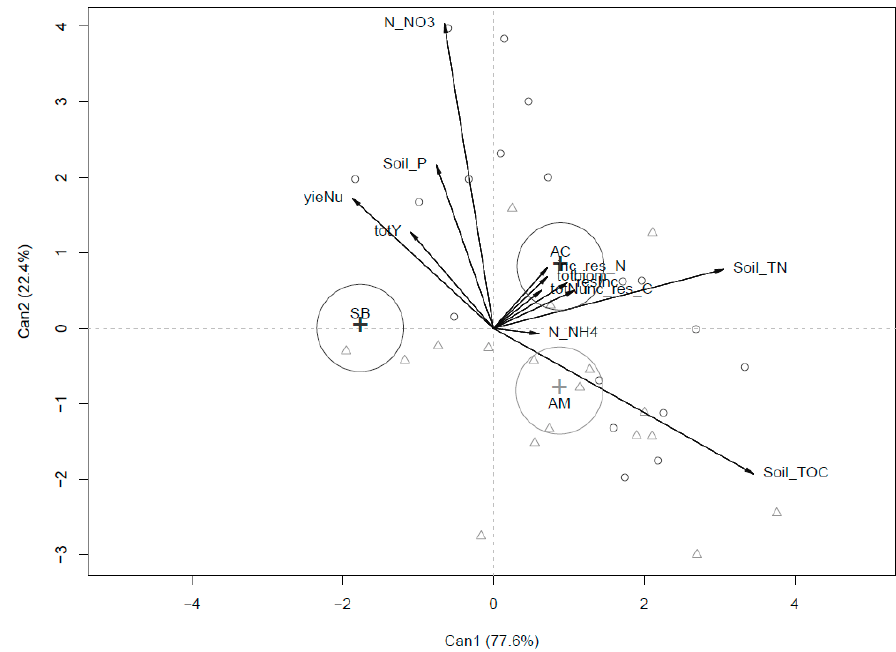
Figure 1. Canonical discriminant analysis (CDA) output for agronomic parameters in the three compared systems (SB, AC and AM) pooling the two-year rotation.